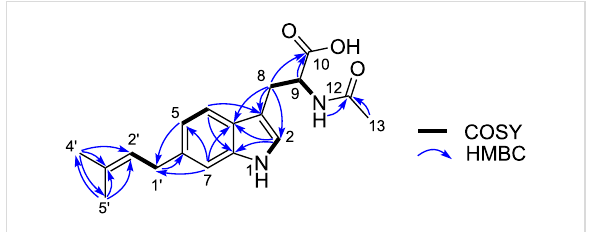
Figure 5: COSY and key HMBC correlations observed for 6 .